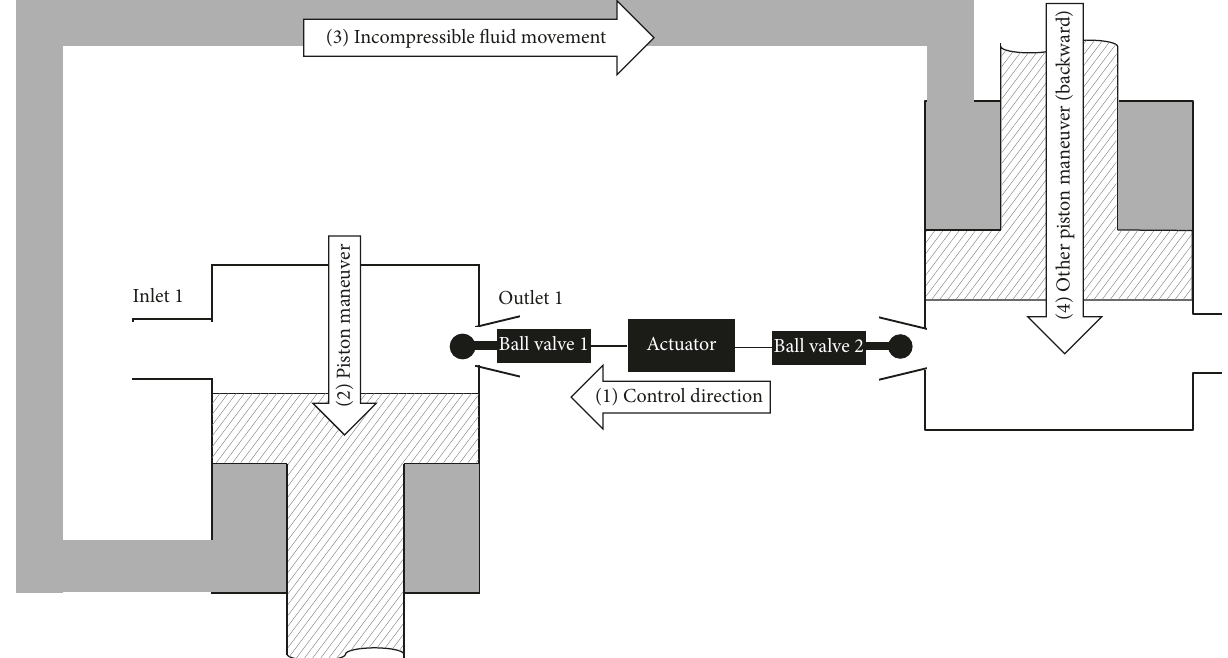
Figure 9: Schematic of actuator linked to two pintles on the same axis with dedicated pistons.